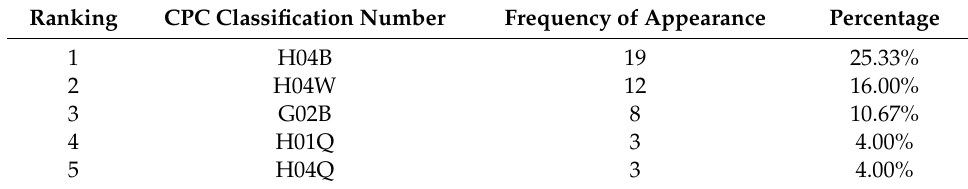
Table 1. Distribution of top 10 Cooperative Patent Classification (CPC) third-order classification codes. Ranking CPC Classification Number Frequency of Appearance